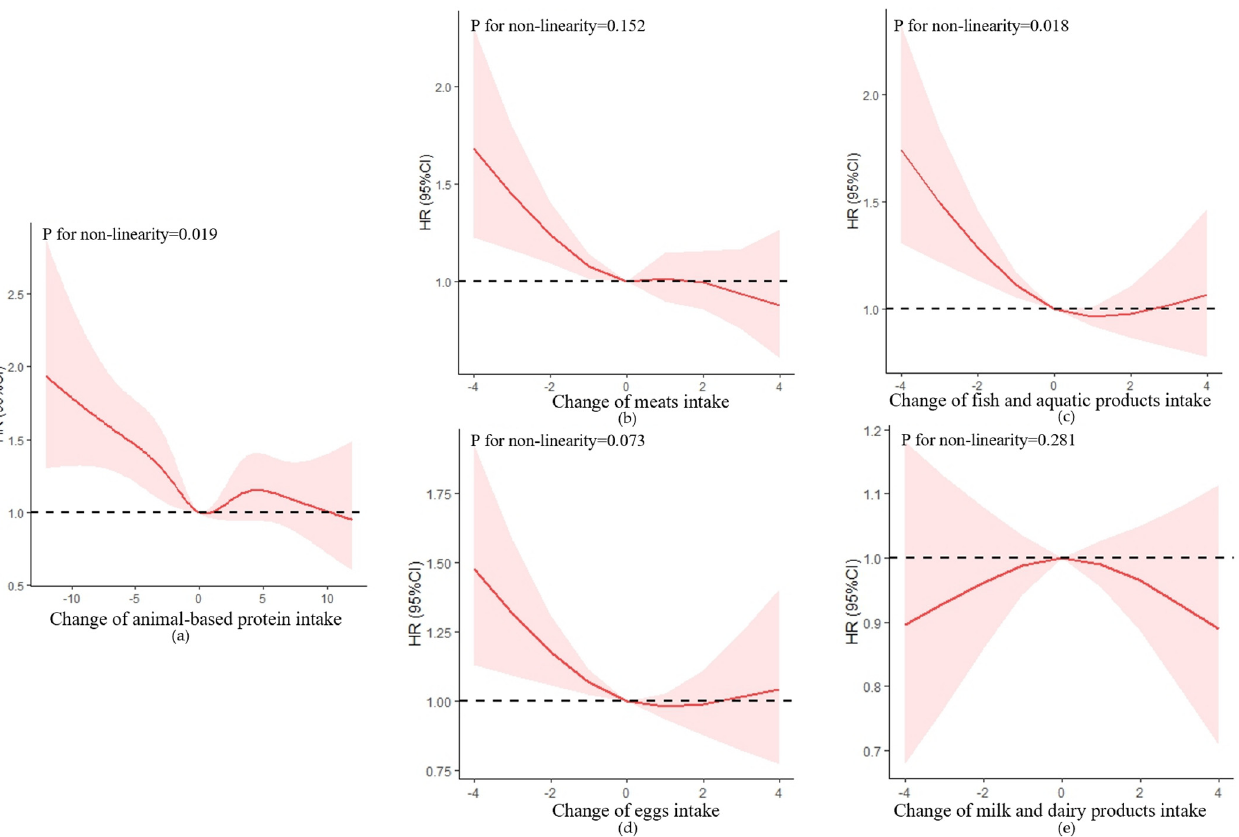
Figure 3. Association between changes in protein intake and cognitive impairment based on re- stricted cubic spline model after adjusting for age (continuous), gender, residence, years of schooling, marital status, economic status, living pattern, tobacco smoking, alcohol drinking, regular exercise, ADL, IADL, BMI, and chronic disease (hypertension, diabetes, heart disease, stroke or CVD, cataract, digestive system disease, arthritis, Parkinson’s disease). ( a ) Change in animal-based protein intake; ( b ) change in meats intake; ( c ) change in fish and aquatic products intake; ( d ) change in eggs intake; ( e ) change in milk and dairy products intake. The red lines represent the HRs, the shades of pink represent the 95% CIs, and the dotted lines represent the reference HRs of one.